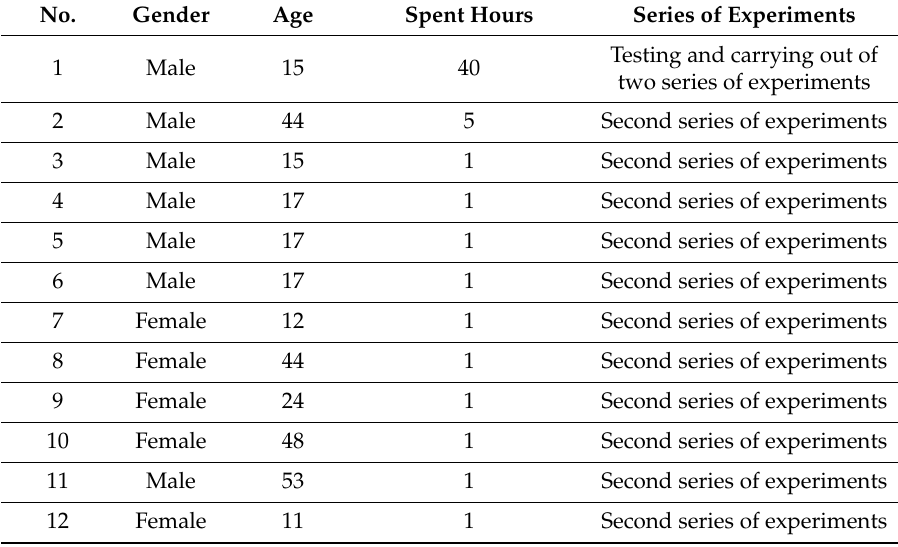
Table 1. Statistics of subjects who took part in